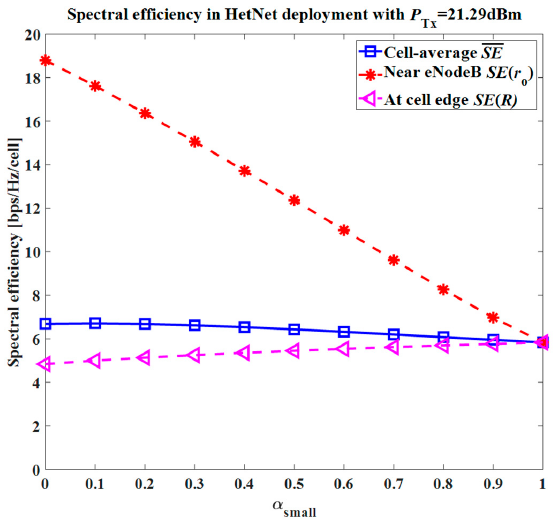
Figure 19. Spectral efficiency for the small cell as a function of distance and α small in the HetNet deployment with small cells near the macro cell edge. Table 2. P max limit for various network deployments.